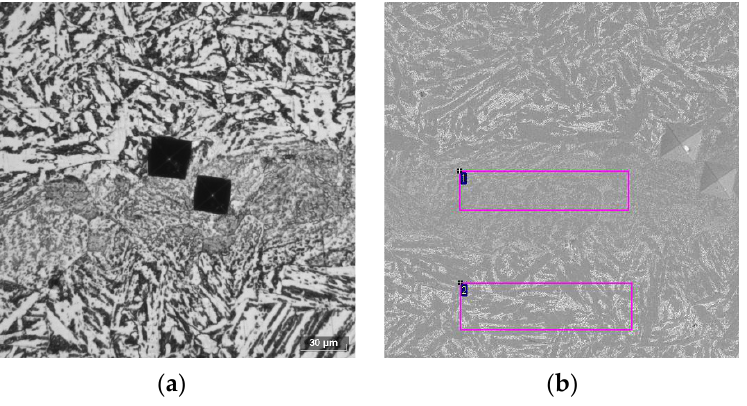
Figure 11. Comparison of LOM ( a ) and SEM ( b ) images of microstructure in segregations and base metal in HRPB. Also shown are areas for determining the chemical composition. Table 4. Chemical composition of the segregations and the base metal of the HRPB sample, wt. %. Element